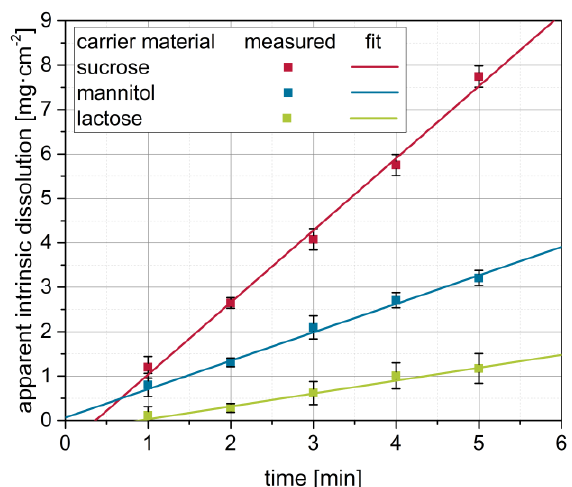
Figure 4. Apparent intrinsic dissolution as a function of time for the di ff erent carrier materials determined according to Ph. Eur. 2.9.29 (with modifications, n = 3). By linear fitting of the data, the apparent intrinsic dissolution rates of the carrier materials were derived as the slope of the regression line.